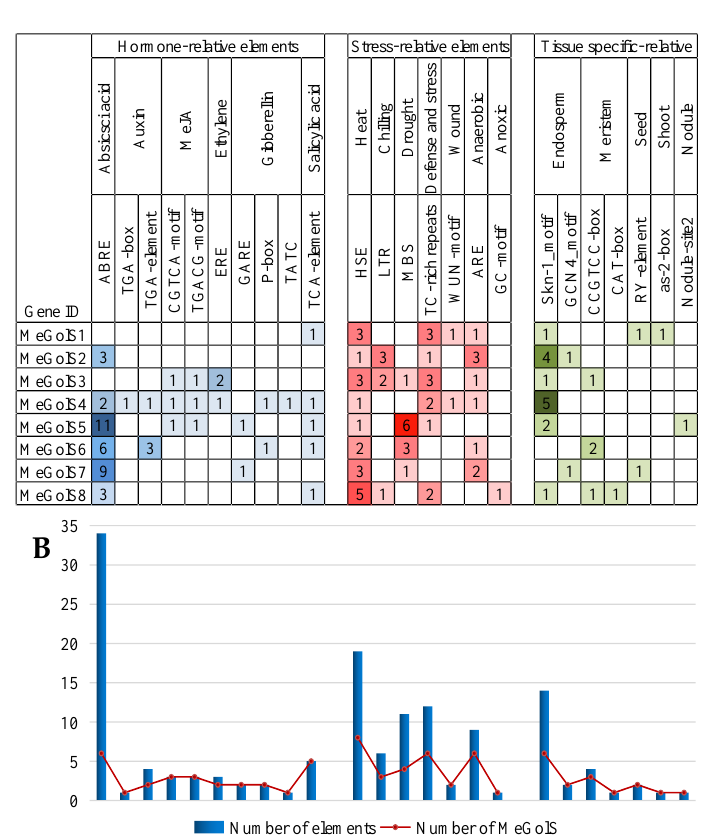
Figure 3. Cis-acting elements in cassava GolS gene promoters. ( A ) Number of every selected cis-acting element in the MeGolS gene promoters. ( B ) Statistics for total number of MeGolS genes containing the corresponding cis-acting elements (red dots) and the total number of cis-acting elements in every MeGolS (blue boxes).